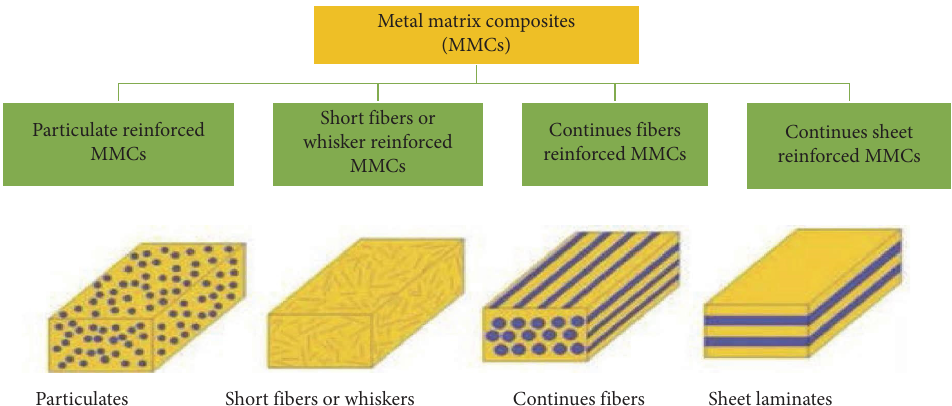
Figure 3: Metal matrix composite reinforcement-based schematic description [43].